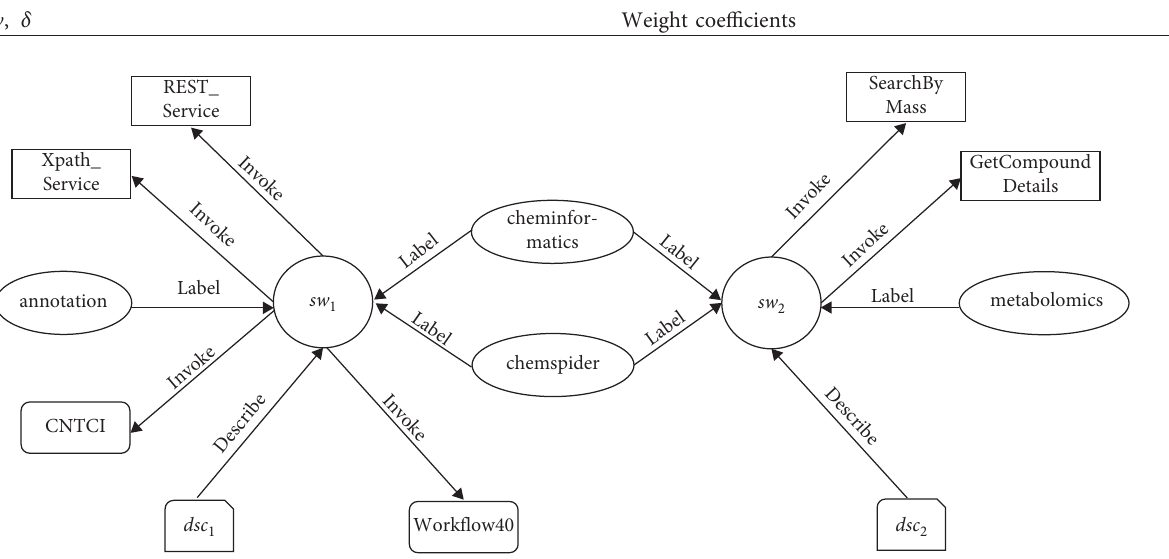
Figure 1: An example of HIN-based scientific workflow representation.